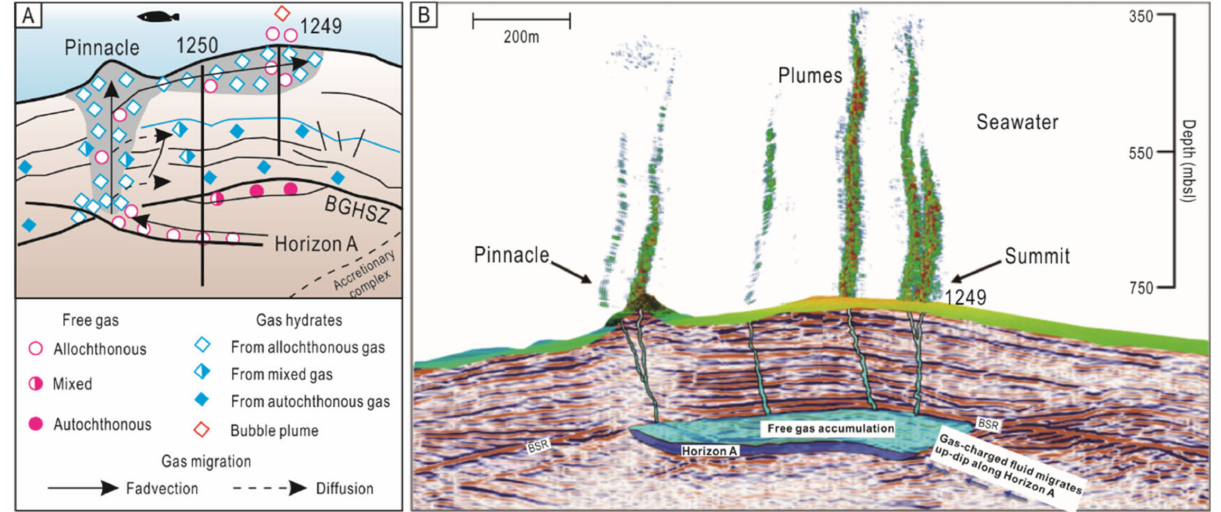
Figure 20. ( A ) Earlier proposed evolution model for hydrate system at the Southern Hydrate Ridge. Deep-sourced gas is stored in permeable Horizon A, where it migrates upward to the Pinnacle before being redirected laterally to the southern Summit Site 1249 via the intersection of Horizon A and the BGHSZ. ( B ) Overpressuring in Horizon A promotes gas transport through the GHSZ by forming free gas migration conduits through fractures. ( A is cited from [115]; B is cited from